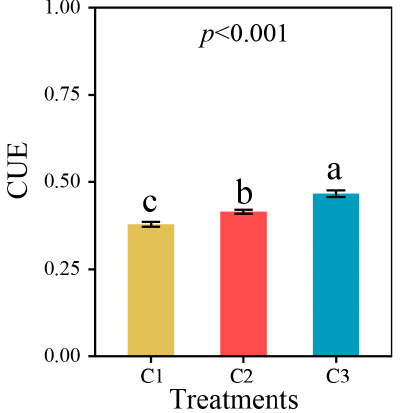
Figure 4. Soil microbial carbon use efficiency in compound soils with different feldspathic sandstone-to-sand ratios. C1, C2, and C3 represent ratios of feldspathic sandstone to sand of 1:5, 1:2, and 1:1. Different lowercase letters represent significant differences at the 0.05 level. Error bars are the standard errors ( n = 3).